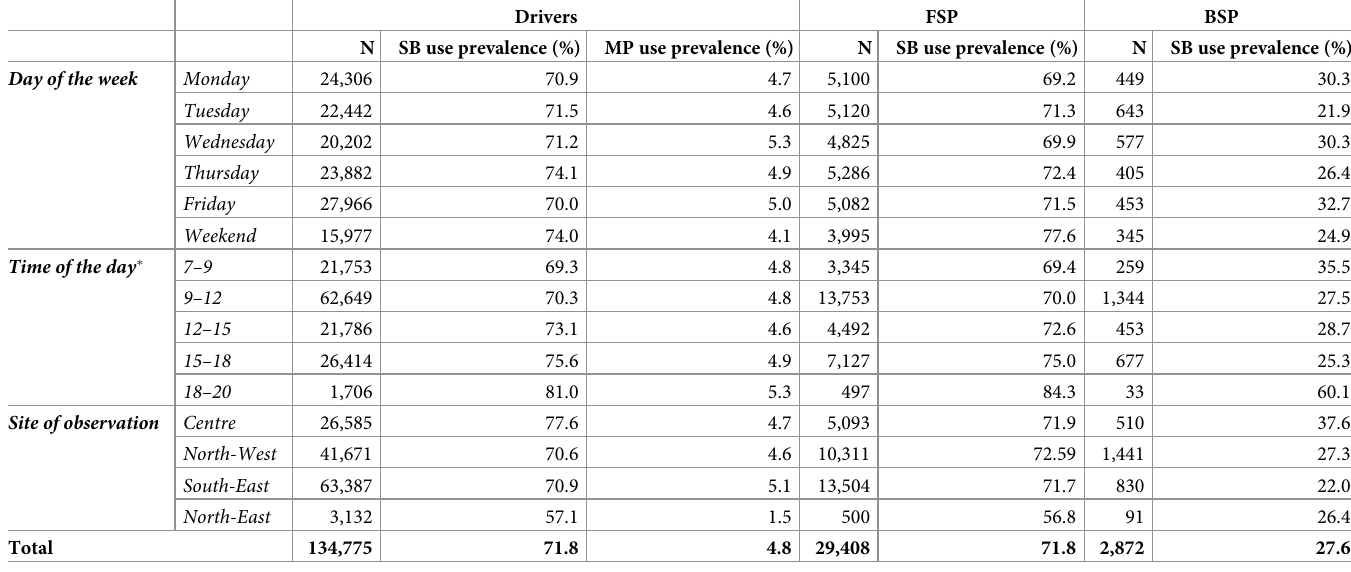
Table 2. Use of SB by driver, FSP, and BSP and use of MP in handheld mode by the driver by day of the week, time of day, and observation site in